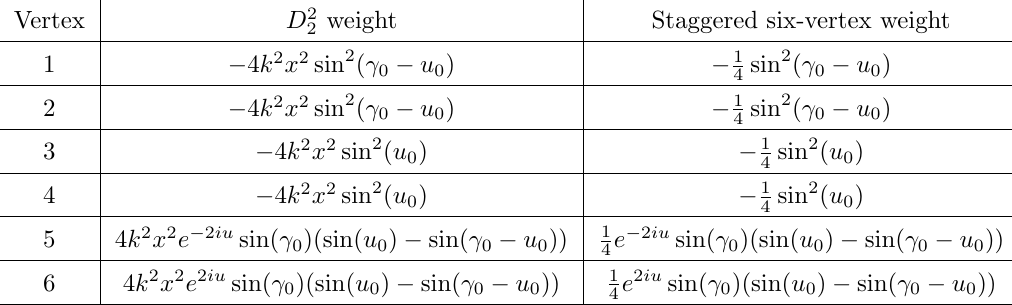
Table 1 . Correspondence between the Boltzmann weights of the D 2 six-vertex model. Vertices 1 to